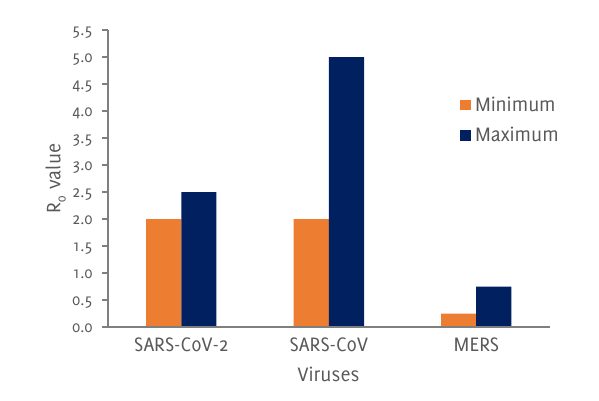
Figure 1. Maximum and minimum R 0 value of the